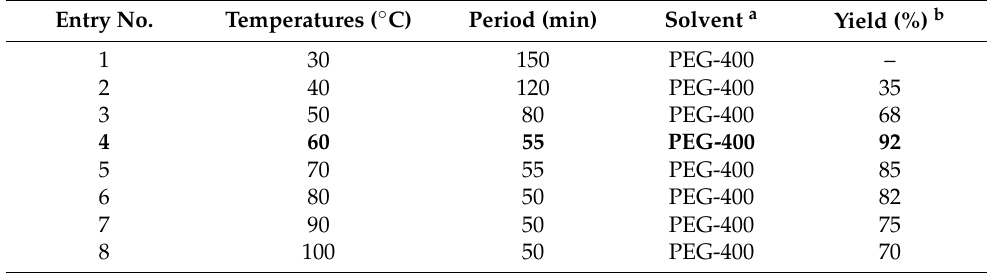
Table 1. Optimization of temperature for the synthesis of 1,5-benzothiazepine derivatives. Entry No. Temperatures ( ◦ C)